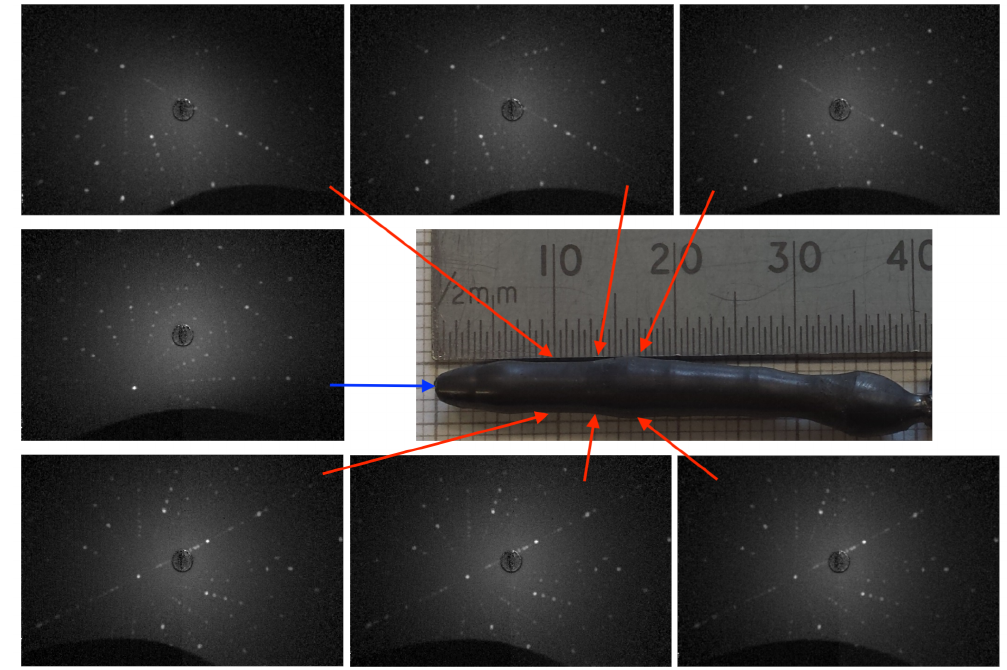
Figure 2. Photograph of a portion of an as-grown boule of HoB 4 prepared by the floating-zone technique. Also shown above the image of the crystal are the X-ray Laue patterns of one of the sides, taken along the crystal length at 3 mm intervals. The corresponding Laue patterns taken on the side at 180 degrees (shown below the photograph of the boule) are mirror images of these patterns. Laue patterns taken of the cross section of the end of the boule, are consistent with one another at several points. One Laue photograph corresponding to scans across the diameter of the crystal is